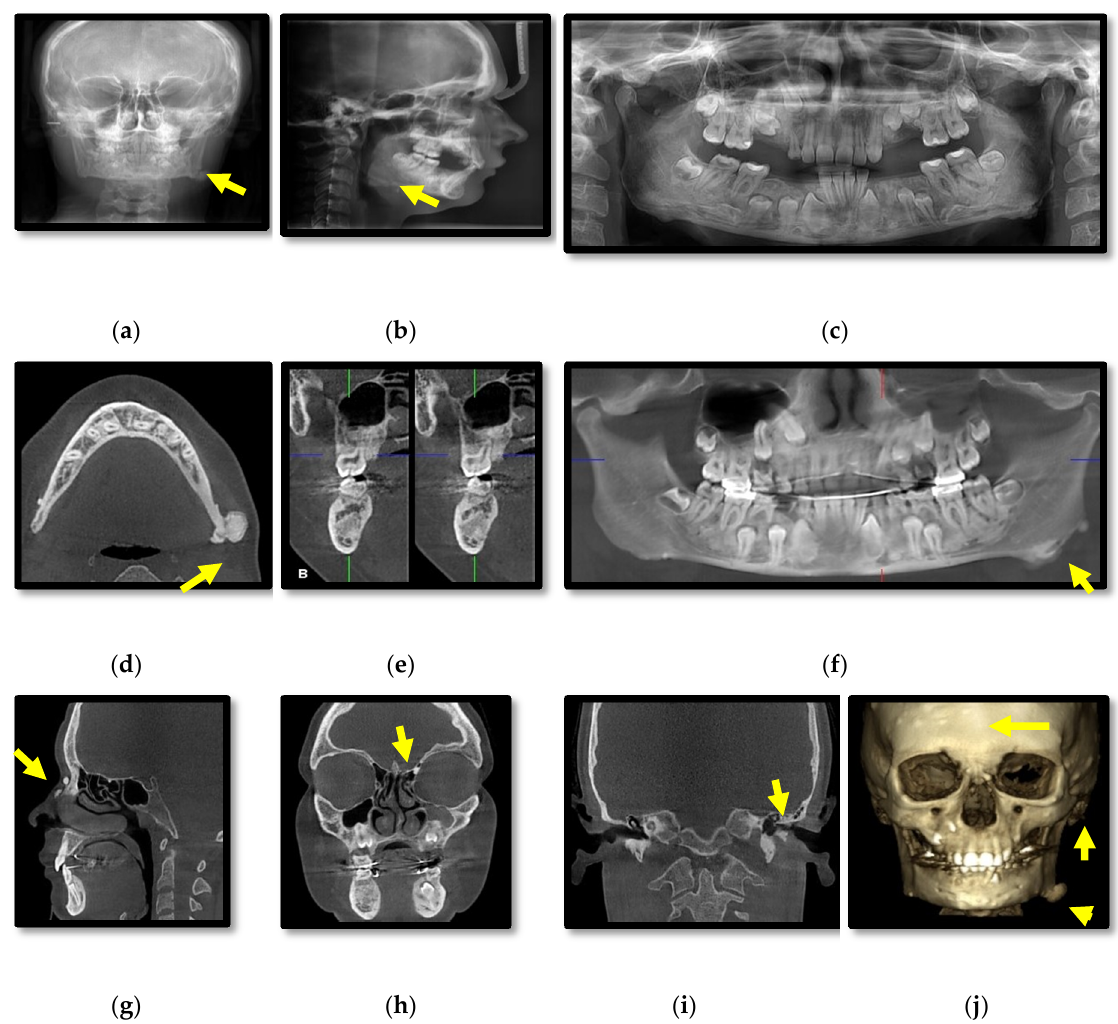
Figure 2. Patient III.1. Cephalometric ( a , b ) and panoramic ( c ) radiographs; Cone-beam computed tomography (CBCT) with axial ( d ), cross-section ( e ), panoramic ( f ), sagittal ( g ), coronal ( h , i ) views and 3D reconstructions of bone tissue ( j ). Cephalometric and panoramic radiographs of the male patient (III.2.) showing multi- ple radiopaque masses with relatively well-defined borders affecting the jaw bones, diffuse sclerosis of the body of the mandible and large masses near the gonions (Figure 3a,b). CBCT axial, cross-section, panoramic, sagittal, coronal, 3D lateral-oblique and 3D sagittal reconstructions showing multiple enostoses located in the medullary bone of the body of the maxilla and mandible, delayed dental eruptions and hypercementosis (Figure 3c–i). Bilateral mushroom-shaped osteomas affect the angle of the mandible, temporal and frontal bones (Figure